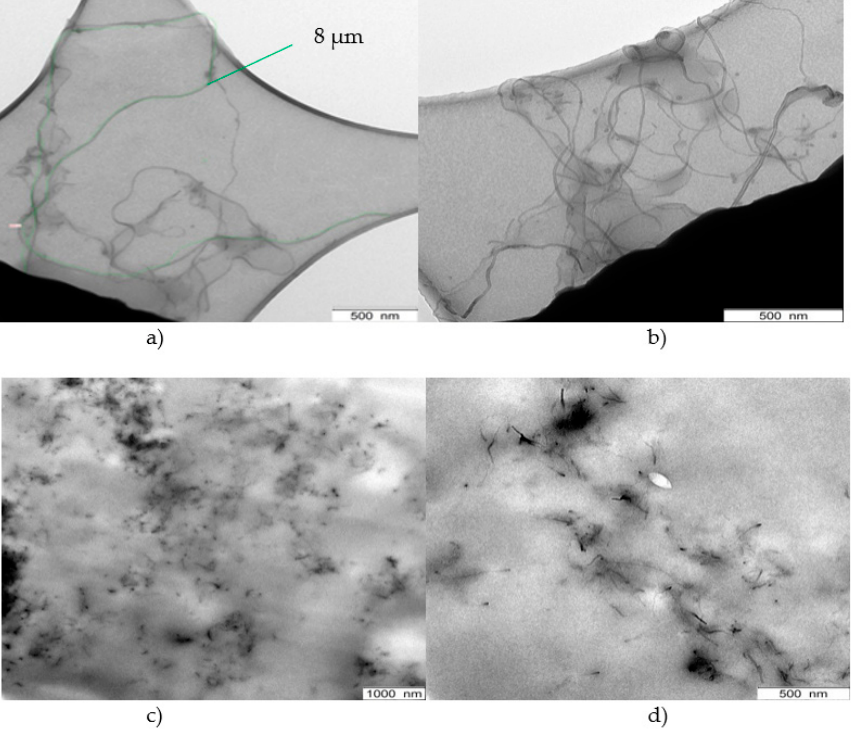
Figure 3. ( a , b ) TEM images of pre-dispersed CNTs (THF, 60 min) and ( c , d ) CNTs in PDMS (THF, 60 min).